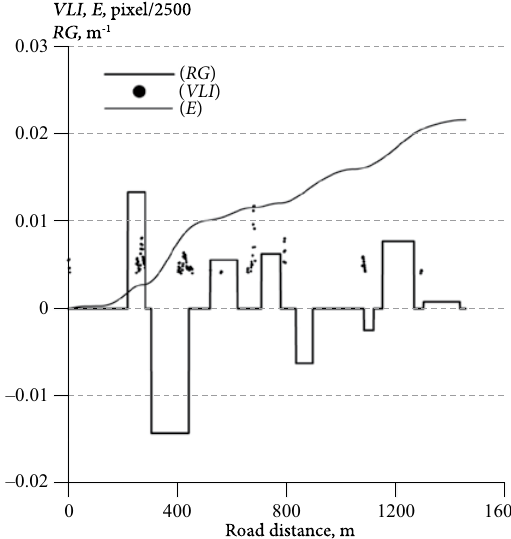
Fig. 4. Relationship between E representative of the load caused by RG